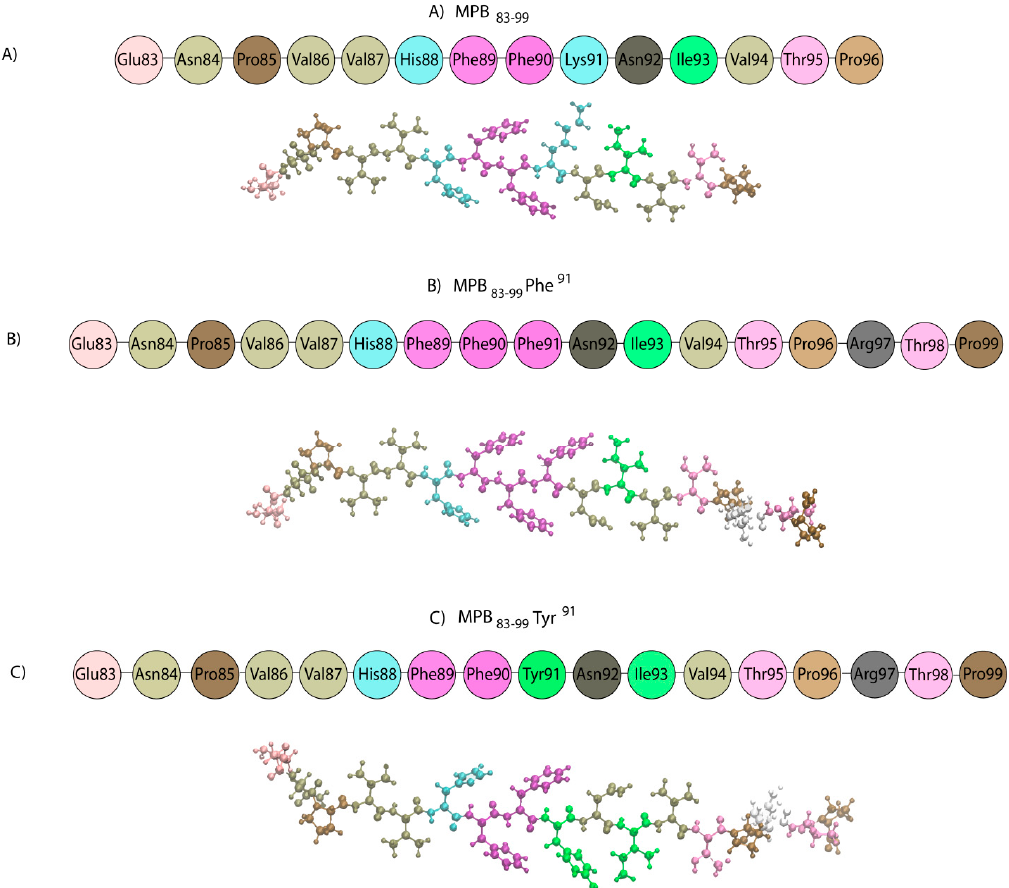
Figure 9. Sequences and 3D low energy structures of ( A ) MBP 83–96 (numbering is according to the human MBP 83–99 epitope) and the two synthetic analogs ( B ) MBP 83–99 (Phe 91 ) and ( C ) MBP 83–99 (Tyr 91 ).